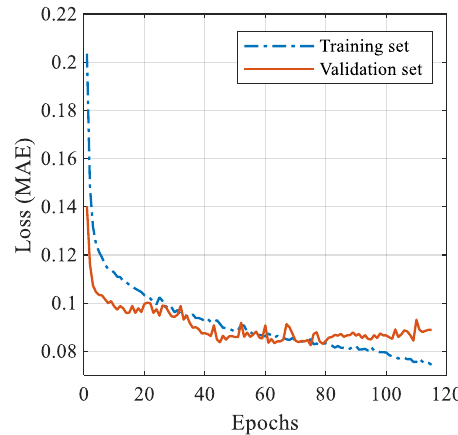
Figure 13. Loss (MAE) history of the CNN.